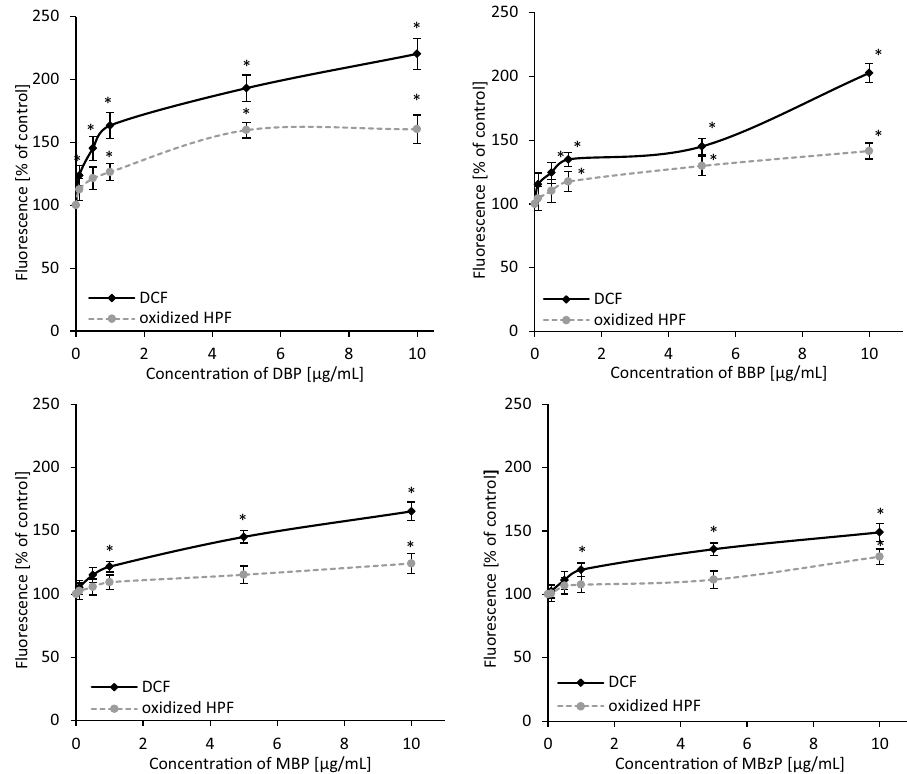
Figure 4. Changes in total ROS (DCF fluorescence) and hydroxyl radical level (oxidized HPF fluorescence) in human PBMCs incubated with DBP, BBP, MBP and MBzP in the concentrations range from 0.01 to 10 µg/ mL for 24 h. (*) Statistically significant different from control (p < 0.05). Each value represents the mean ± SD calculated from 5 individual experiments (5 blood